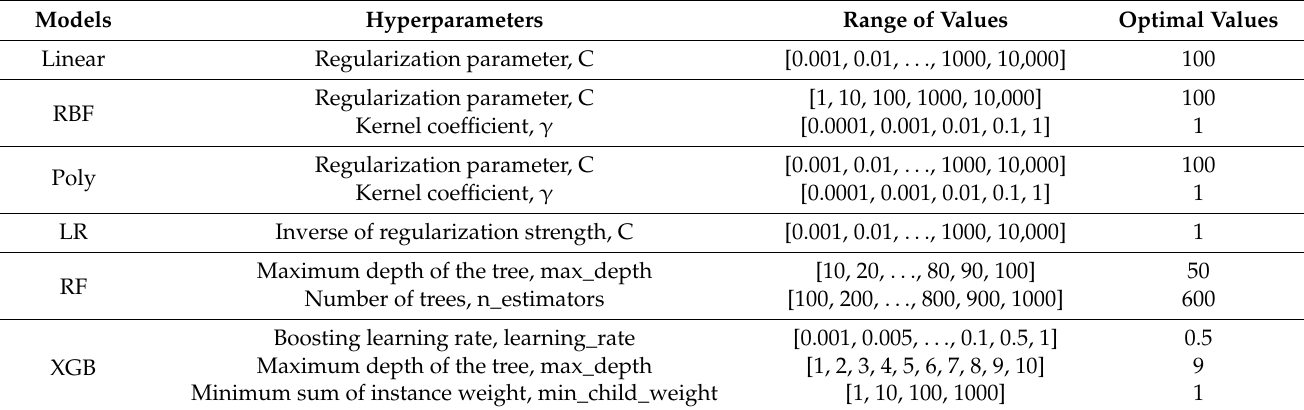
Figure 13. 10-fold CV accuracy for parameter-tuned classification methods (Case 3). Table 7. Hyperparameter tuning for each classification method (Case